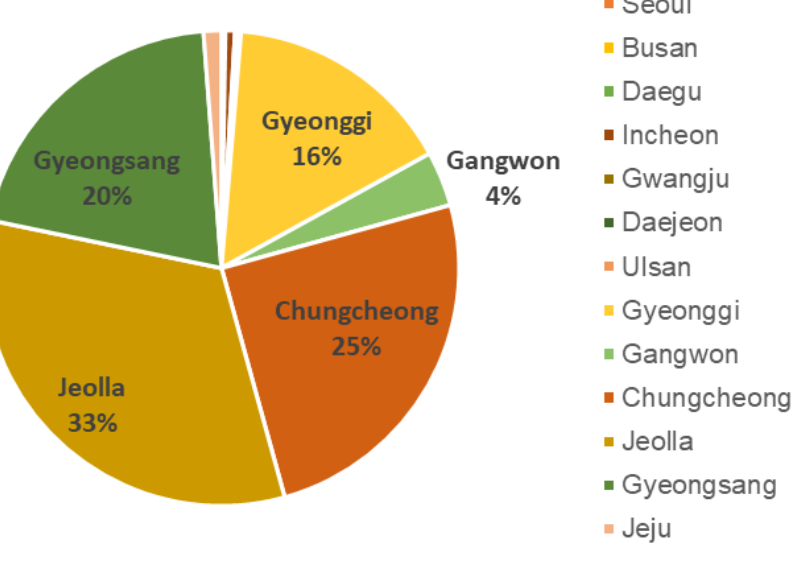
Figure 3. Livestock ratio by region (2017). Table 1. Livestock statistics by animal type and region